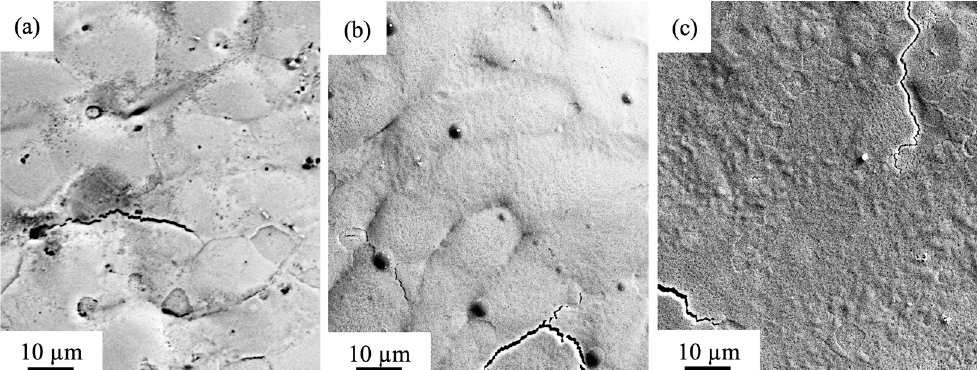
Figure 4. SEM analysis of the surface of the Al-Co-Cr-Fe-Ni sample after HCPEB with the different electron beam energy density ( a ) 10 J/cm 2 ; ( b ) 20 J/cm 2 ; ( c ) 30 J/cm 2 .